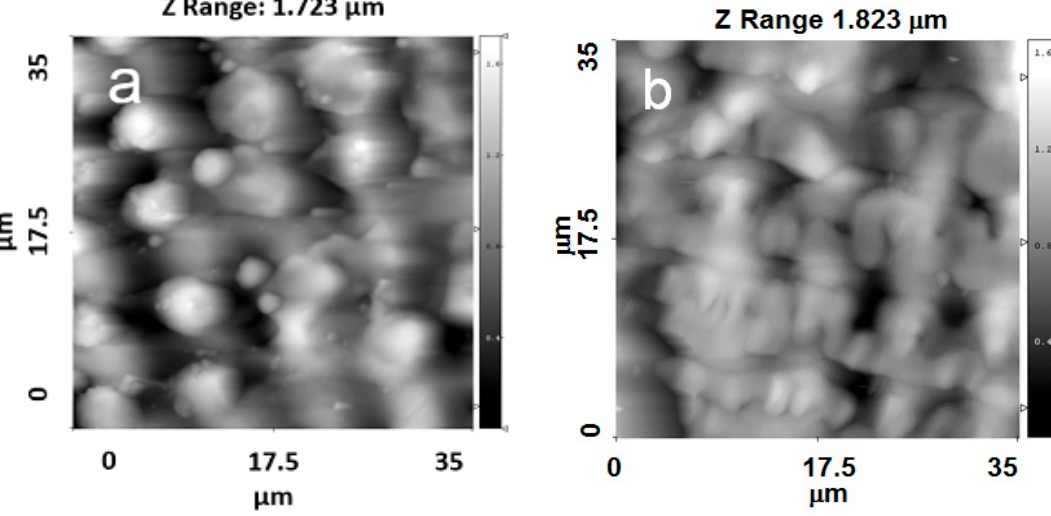
Figure 5. AFM images of the topographies of Ti samples with crossed grooves with a periodicity of approximately 8.4 µm. ( a ) 35 × 35 μm (cid:2870) ; ( b ) 35 × 35 μm (cid:2870) with a HA film.